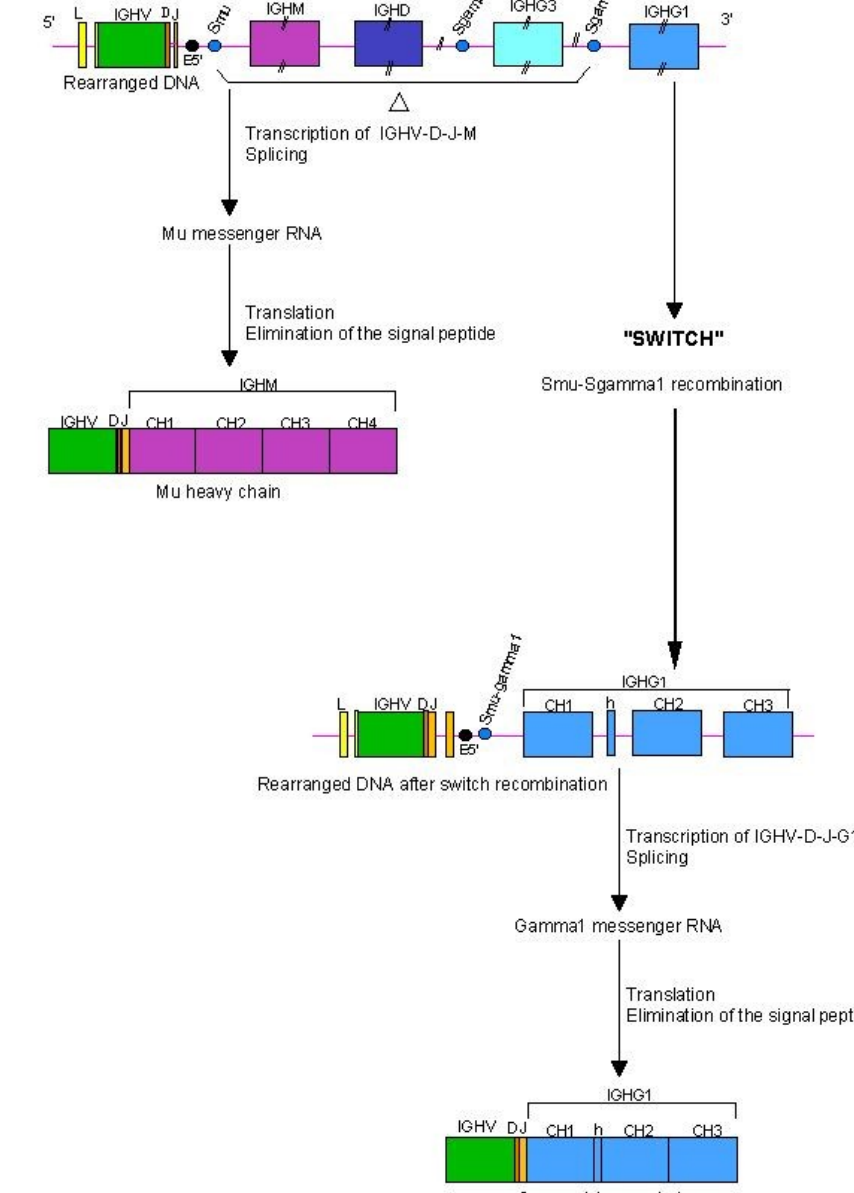
Figure 10. Class switch IgM-IgG1: Smu-Sgamma1 recombination [2]. In a B cell which expresses IgM on the cell surface, a productive rearranged IGHV-D-J gene on one chromosome 14 is transcribed with the IGHM gene. Before the switch (S) recombination, all the IGHC genes are present in the IGH locus. During the switch recombination, a novel DNA rearrangement occurs in the IGH locus, between the Switch mu (Smu) sequence and another S sequence located in 5 ′ of a more downstream IGHC gene (for example, Sgamma1 upstream of IGHG1). This leads to the deletion of the intermediary DNA and to the loss of the IGHC genes located between the two S sequences which recombine. The enhancer (E) located between the most 3 ′ IGHJ and Smu is retained during the switch recombination [2]. (With permission from M-P. Lefranc and G. Lefranc, LIGM, Founders and Authors of IMGT ® , the international ImMunoGeneTics information system ® , http://www.imgt.org).